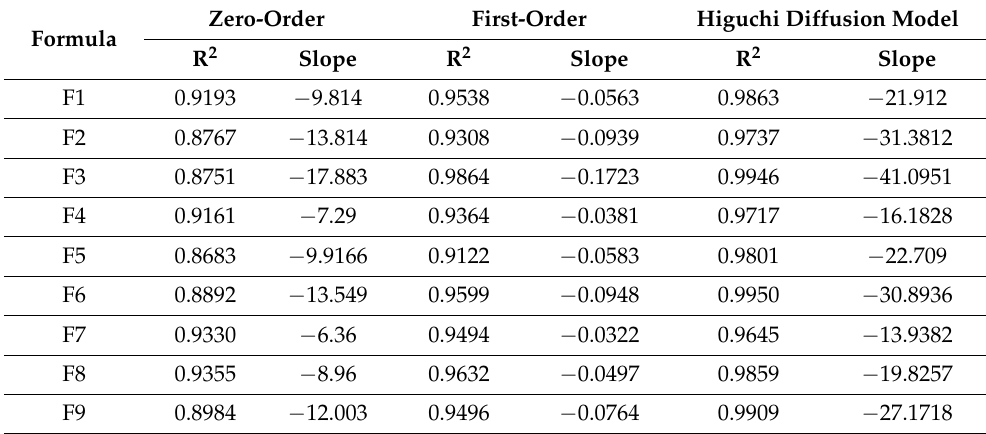
Table 2. Kinetic release data of different SIM-loaded cubosomes.